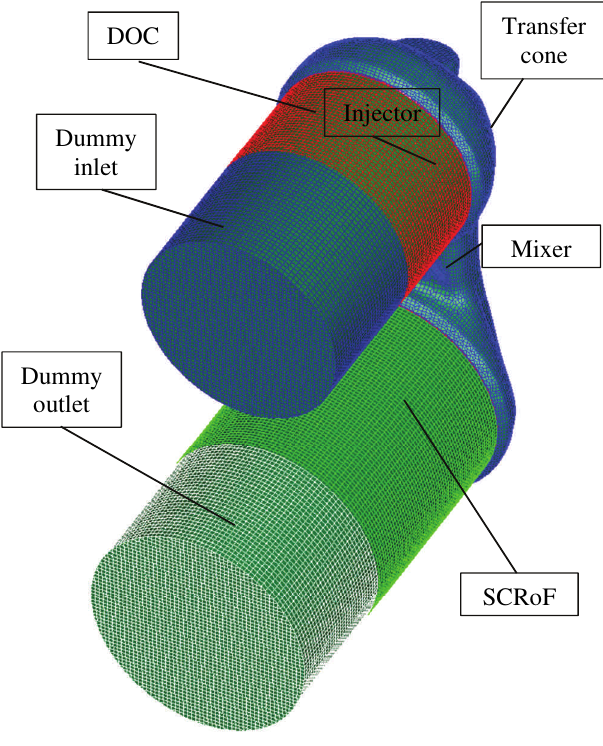
Fig. 1. The geometry and